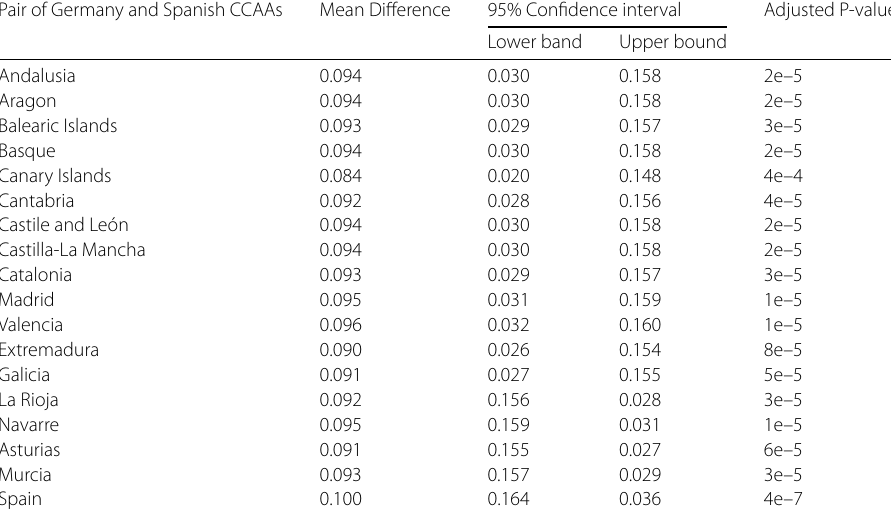
Table 13 HSD Tukey test results filtered by for the pair of CCAAs-countires which include Germany Pair of Germany and Spanish CCAAs Andalusia